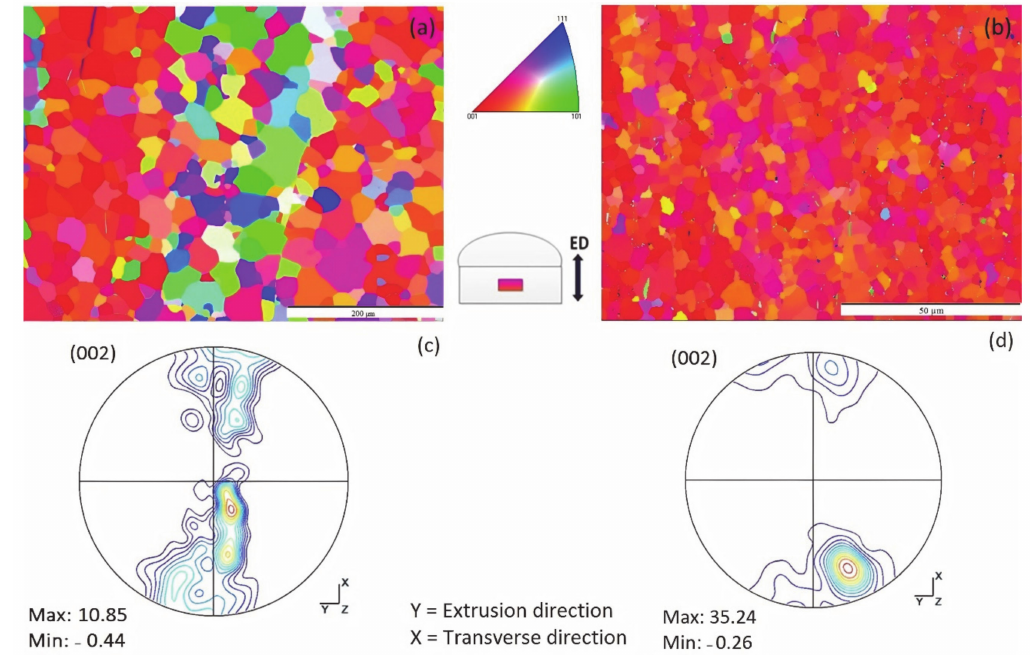
Figure 4. IPFs of ( a ) Pure Mg ( b ) Mg-5Sn-2Y along with their corresponding PFs in ( c ) and ( d ),